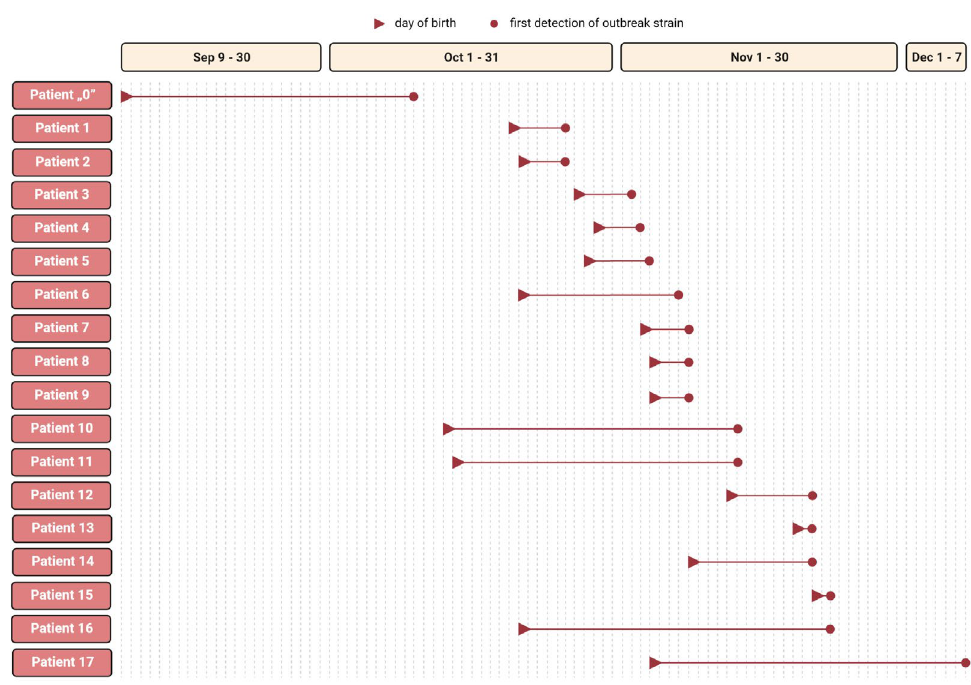
Figure 1. Outbreak timeline.